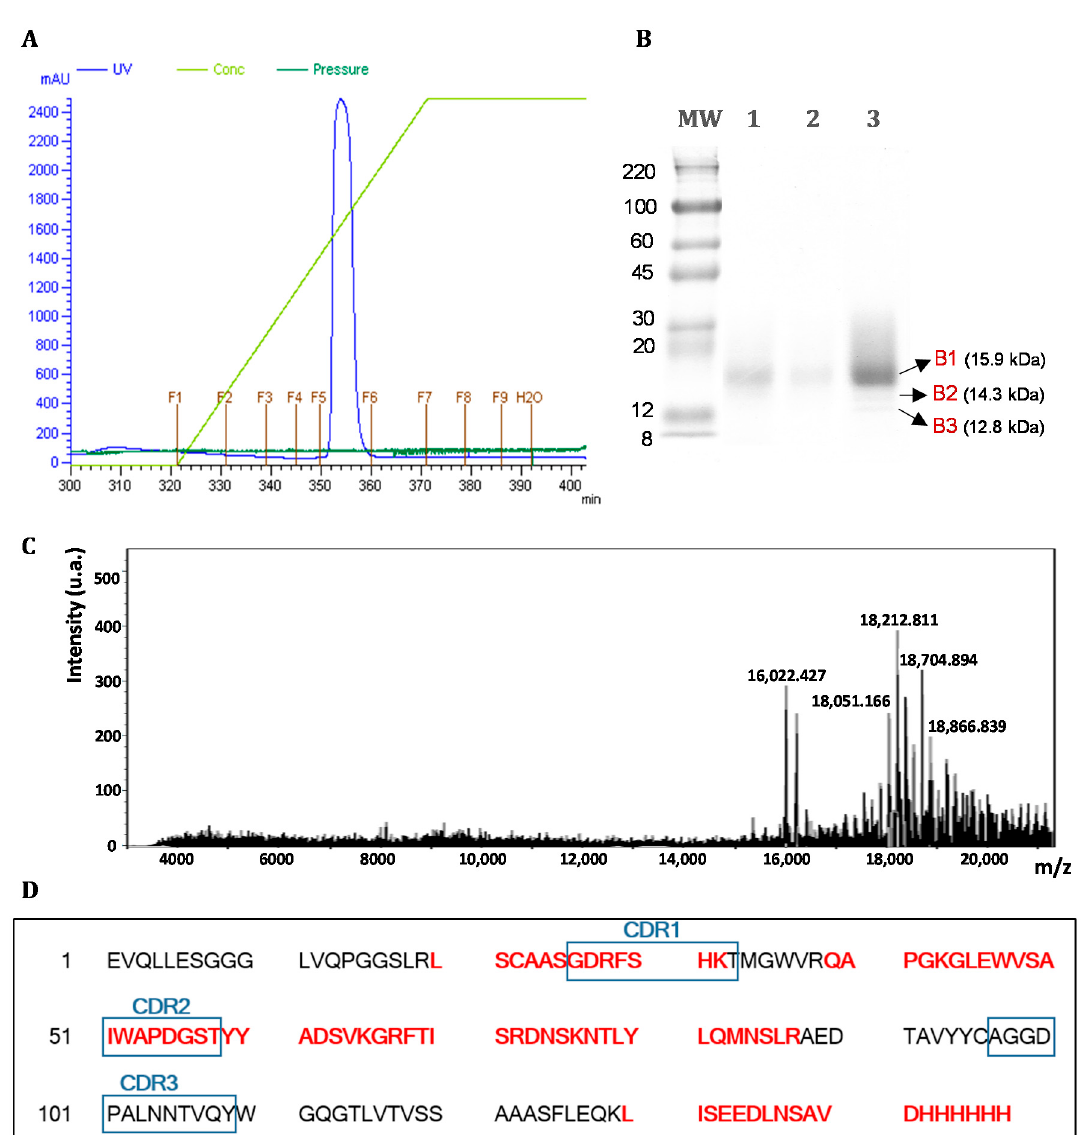
Figure 3. ( A ) Immobilized metal affinity chromatography (IMAC) profile for the purification of the recombinant dAb8E from the supernatant of clone 4 transformed with vector pMJA302. ( B ) Analysis of the purification steps by SDS-PAGE electrophoresis (under reducing conditions). Lanes 1 and 2 correspond respectively to the analysis of 10 µL the induced supernatant prior and after to purification by means of IMAC, and lane 3 correspond to the analysis of the main purification peak (fraction 5) after the dialysis step (2 µg of protein). The indicated bands were excised, trypsinized and the dialysis step (2 µ g of protein). The indicated bands were excised, trypsinized and the peptide mass the peptide mass fingerprinting analysis performed. MW (Molecular marker) corresponds to ColorBurst Electrophoresis Marker (Sigma-Aldrich). ( C ) MALDI-TOF mass spectra of the intact Marker (Sigma-Aldrich). ( C ) MALDI-TOF mass spectra of the intact dAb8E produced in P . pastoris . ( D ) dAb8E produced in P . pastoris . ( D ) Mass fingerprinting analyzed from band 1 (B1): matched peptides Mass fingerprinting analyzed from band 1 (B1): matched peptides from MS spectra after Mascot search from MS spectra after Mascot search are represented in red bold font in the amino acids sequence of are represented in red bold font in the amino acids sequence of the dAb8E (GenBank accession number the dAb8E (GenBank accession number MW030686). The dAb8E complementarity determining MW030686). The dAb8E complementarity determining regions (CDR1-3) are highlighted in blue regions (CDR1-3) are highlighted in blue boxes.